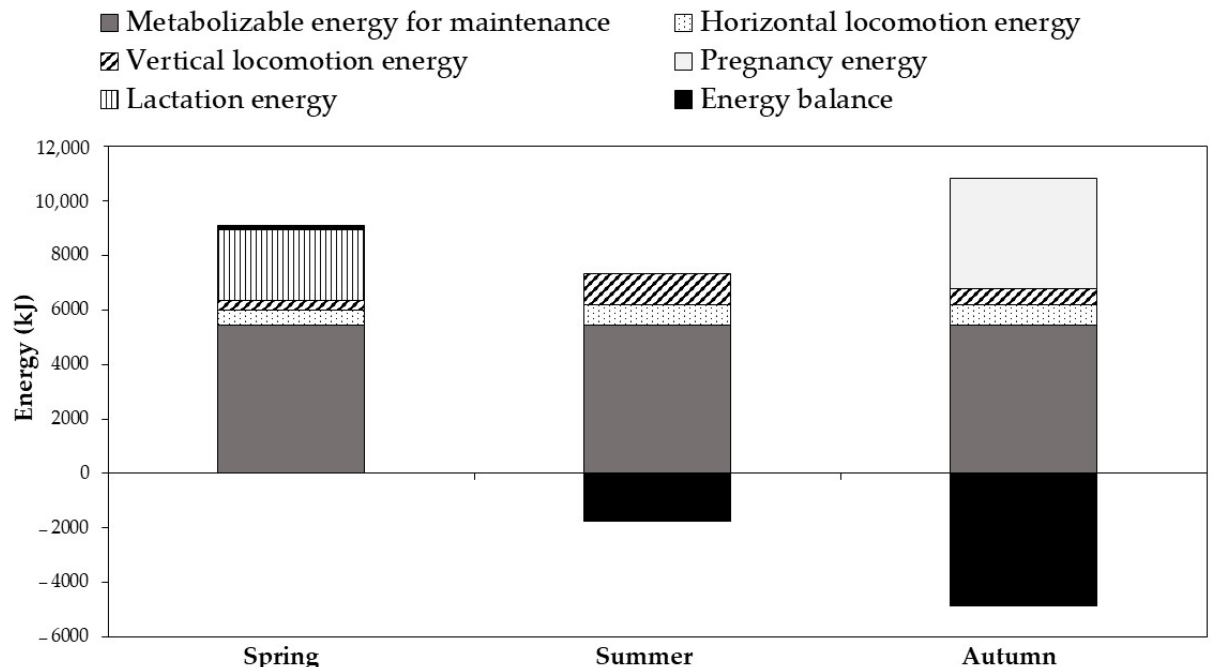
Figure 4. Estimation of the seasonal energy requirements (metabolizable energy for maintenance, locomotion, lactation, and pregnancy) and the energy balance of the experimental goats grazing in a Mediterranean forest rangeland of northern Morocco.